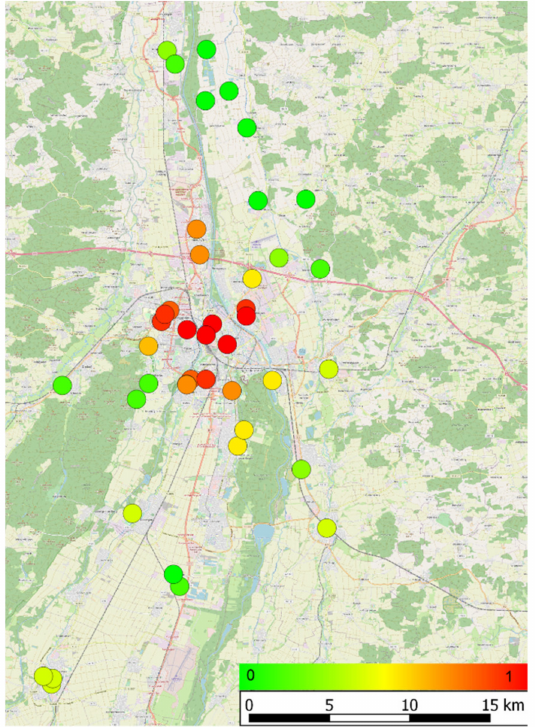
Figure 1. Location and Urbanity Index (UI) for all observed Betula pendula individual trees. (0: green (rural), 1: red